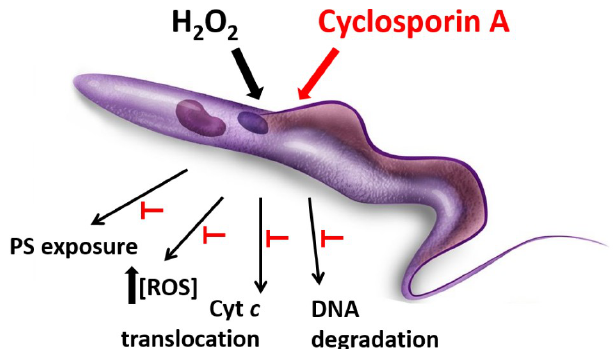
Figure 2. Protective effect of Cyclosporin A against oxidative stress. T. cruzi epimastigotes incubated with H 2 O 2 exhibit cell death features such as mitochondrial membrane depolarization, parasite DNA fragmentation, phosphatidylserine (PS) exposure to the external membrane surface, an increase in reactive oxygen species production and cytochrome c translocation from mitochondrion to cytosol. All these events do not occur when parasites are pre‐treated with 1μM Cyclosporin A.